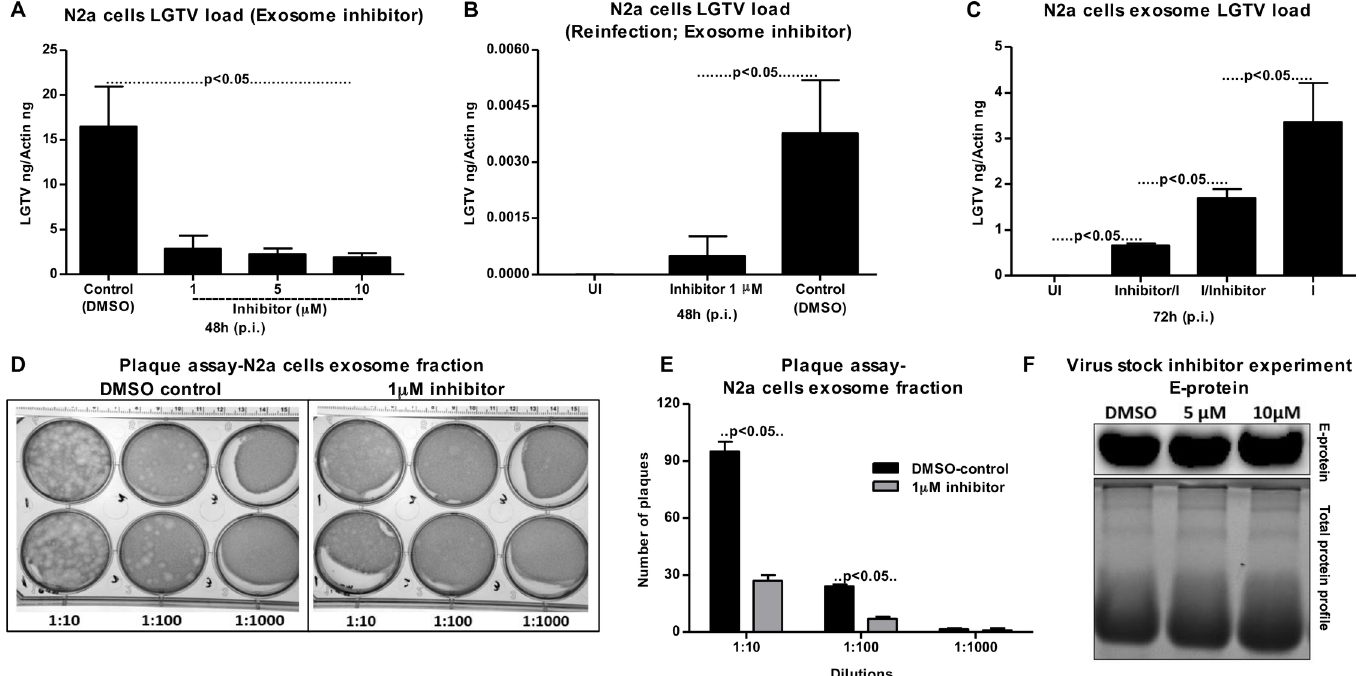
Fig 5. Treatment of neuronal N2a cells with exosome inhibitor affectsLGTV infection, if treated either before or after infection. (A) QRT-PCR analysisshowinglevels of LGTV in exosomesisolated from N2a cells at 48 h p.i. in the presenceof exosomes-inhibitorat different concentrations (1, 5, 10 μ M). 1 x 10 5 N2a cells were pre-treatedwith inhibitorfor 4 h followedby infection with LGTV (6 MOI). Exosomesisolated from N2a cells treated with DMSO serve as loadingcontrol. (B) Levels of LGTV in N2a cells at 48 h p.i. infected by treatment with exosomes (20 μ l) isolated from control or inhibitor-treated N2a cells is shown. UI indicatesuninfectedcells that serve as control. (C) QRT-PCR analysisshowinglevels of LGTV in N2a cells at 72 h p.i. Uninfected (UI) N2a cells were treated with 5 μ M inhibitor.For LGTV-infection, N2a cells were first treated for 4 h with inhibitor then followedby infection (Inhibitor/I) or cells were first infected for 4 h with LGTV and then treated with inhibitor(I/inhibitor). LGTV (6 MOI) was used to infect 1 x 10 5 N2a cells in the presence(5 μ M) or absence of inhibitor.LGTV transcript levels were normalized to mouse beta-actin.(D) Plaqueassays performed with different dilutions(1:10, 1:100, 1:1000) of exosomesfraction isolatedfrom control DMSO-treated or inhibitor-treated N2a cells is shown. A representative image from two independent experiments is shown. (E) Quantitative assessment of number of plaques from DMSO-treated or inhibitor-treated (D) is shown. P value determined by Student’stwo-tail t test is shown. (F) Laboratory virus stocks treated with either GW4869 inhibitor(5 and 10 μ M) or DMSO as control is shown. Representative data in other panels is shown from at least three independent